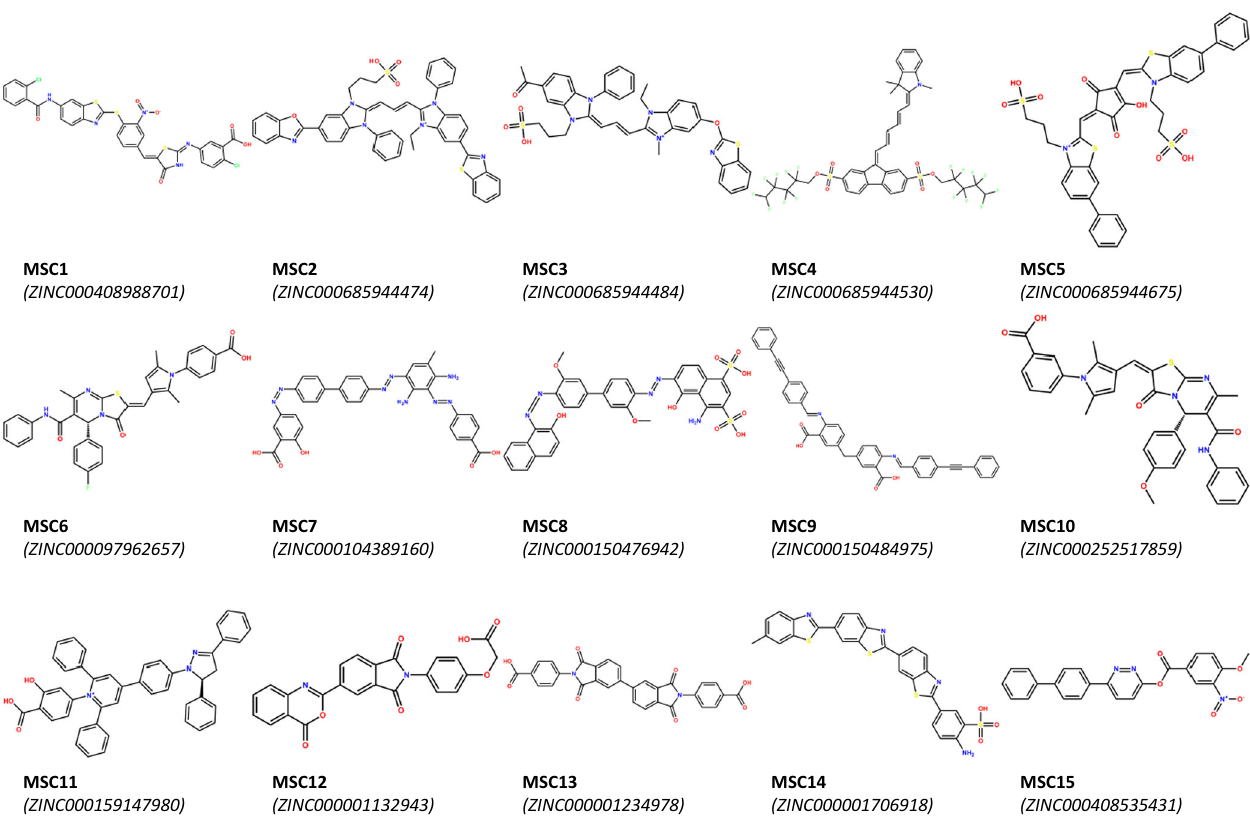
Fig. 4 Manually selected compounds for QM